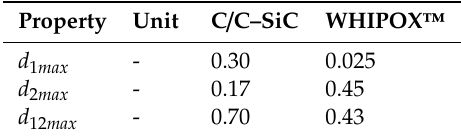
Table 5. Damage limits for stress-based Tsai-Wu failure criterion.